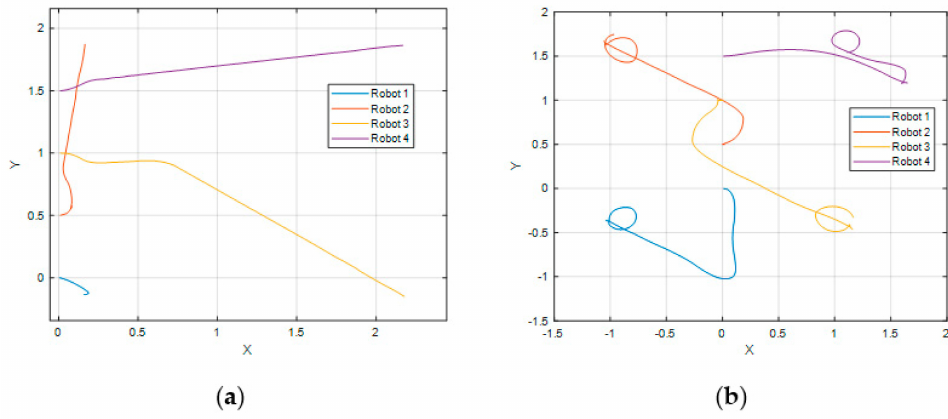
Figure 24. Movement of the robots in the plane in the comparison tests with collision avoidance but without an end point reference: ( a ) Scheme proposed in this paper; ( b ) scheme proposed in [17].